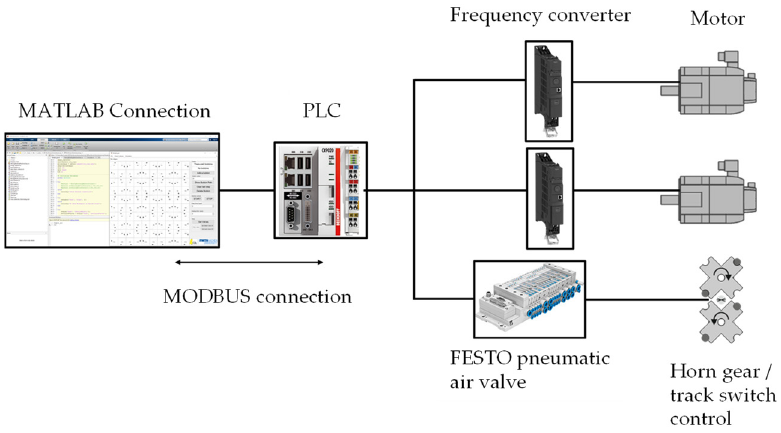
Figure 6. Schematic illustration of the programmable logic controller (PLC) connection.